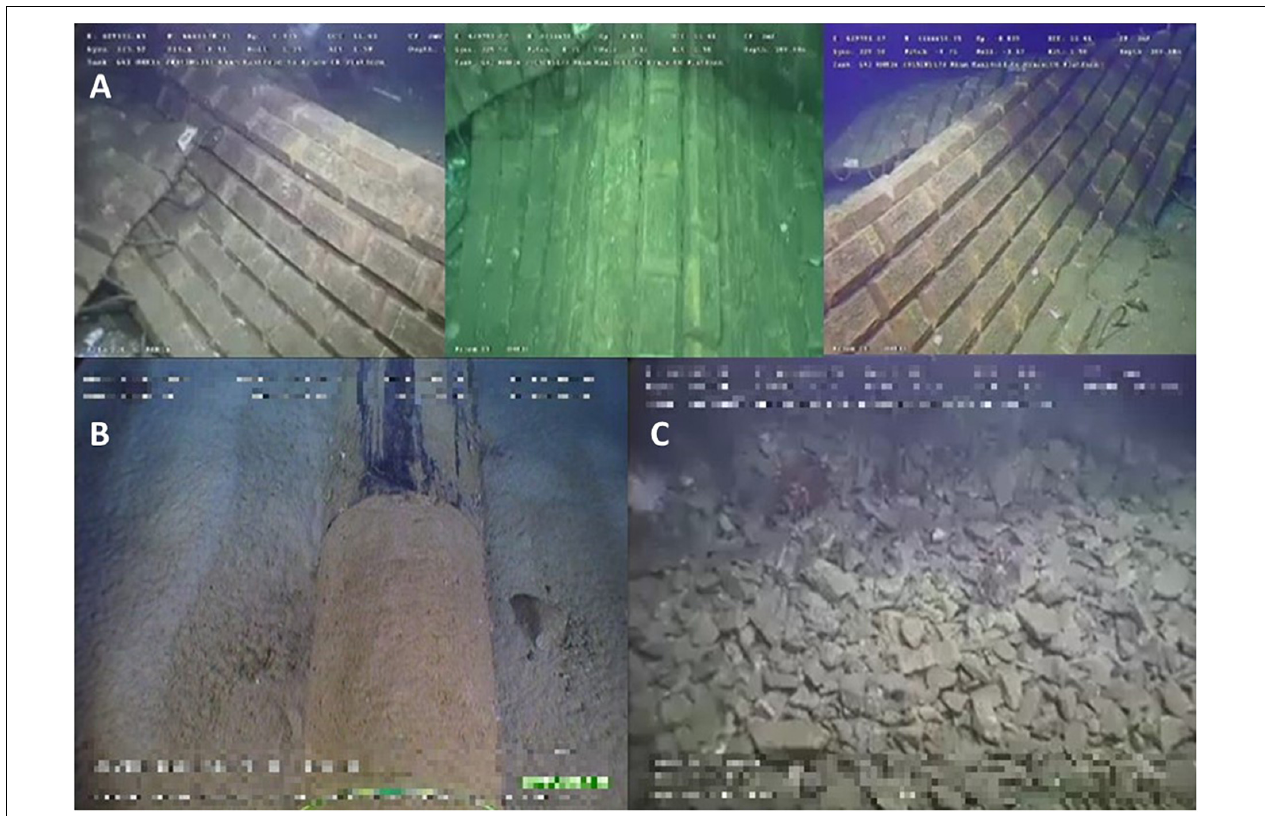
FIGURE 2 | (A) Format of ROV footage playback with three camera views (top three images left to right; port, central, and starboard) observed in synchronisation. (B) Bare pipeline and (C) rock dump.